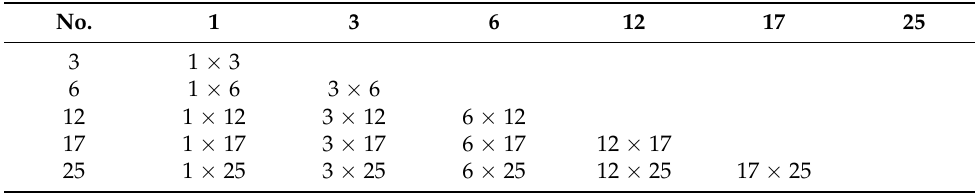
Table 2. Questionnaire design